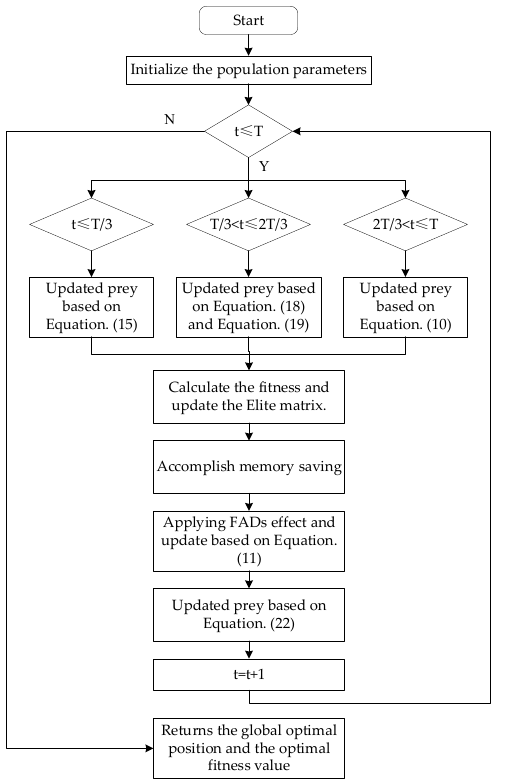
Figure 3. Flow chart for the proposed FMMPA. The pseudo-code of the proposed FMMPA is shown in Algorithm 1.